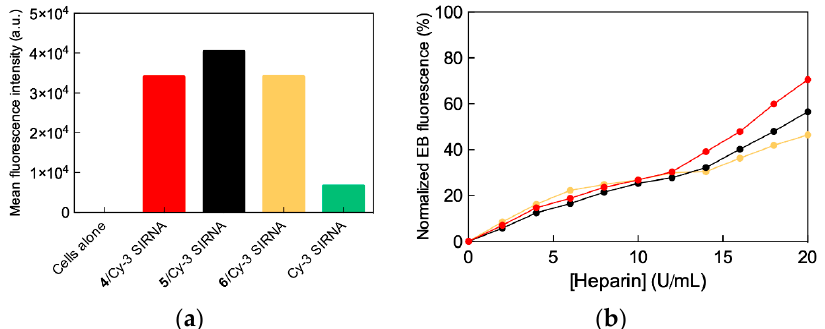
Figure 5. ( a ) The mean fluorescence intensity of PC-3 cells treated with siRNA labeled with the fluorescent dye Cy-3 in complex with self-assembled nanovectors 4 , 5 , and 6 (50 nM siRNA, N/P = 10). Non-treated cells and cells treated with labeled siRNA alone were used as control. ( b ) siRNA release from their complexes with micelles of dendrons 4 (red), 5 (black), and 6 (yellow) as assessed using EB displacement assay performed in the presence of heparin. Adapted from [7] with the permission of John Wiley and Sons, 2016.